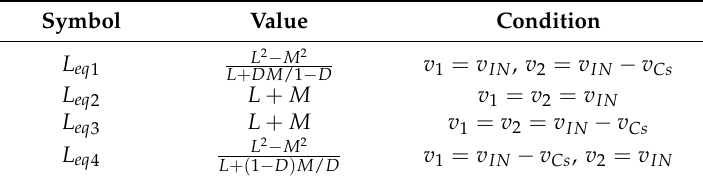
Figure 2. The equivalent circuit of the inversely coupled inductor L B . Table 1. Equivalent inductances in the interleaved boost